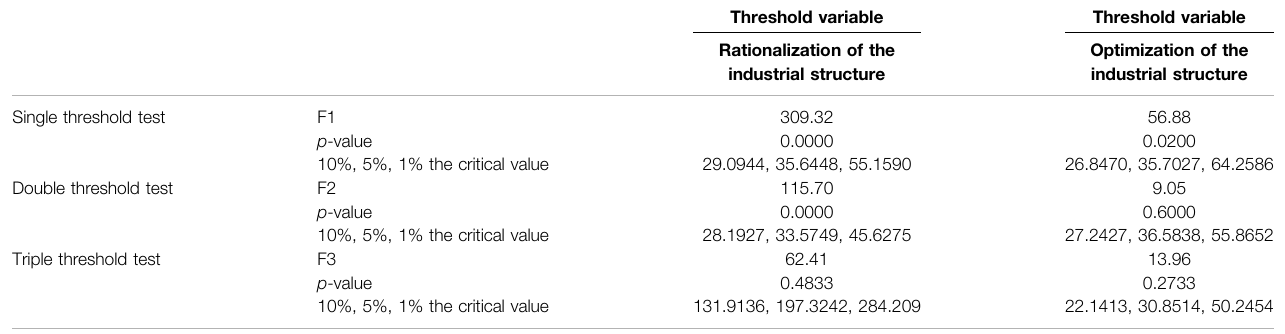
TABLE 2 | Existence test of a threshold effect.